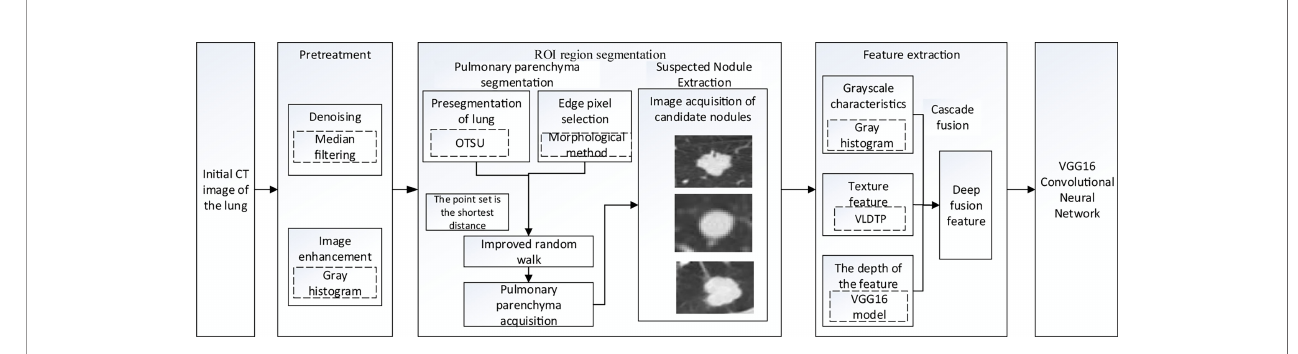
FIGURE 1 | Overall roadmap of